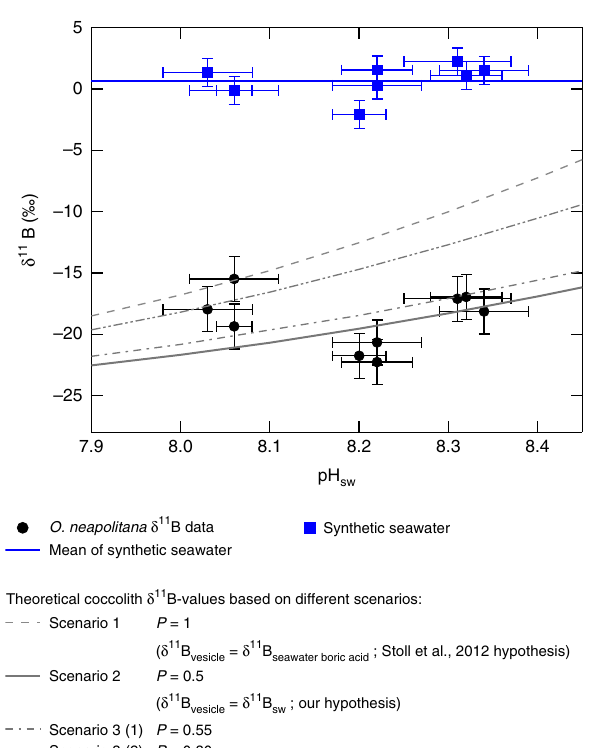
Fig. 1 Impact of transporting different boron species to calci fi cation site on coccolith boron isotopic composition. The relationship between δ 11 B and pH SW for three B-transport scenarios (gray dash line, gray solid line, gray dash-dot line, and gray dash-double dots line for scenarios 1, 2, 3(1), and 3(2), respectively) are compared to δ 11 B-pH SW relationships for coccoliths from the present study (solid black circles). The B-transport scenarios